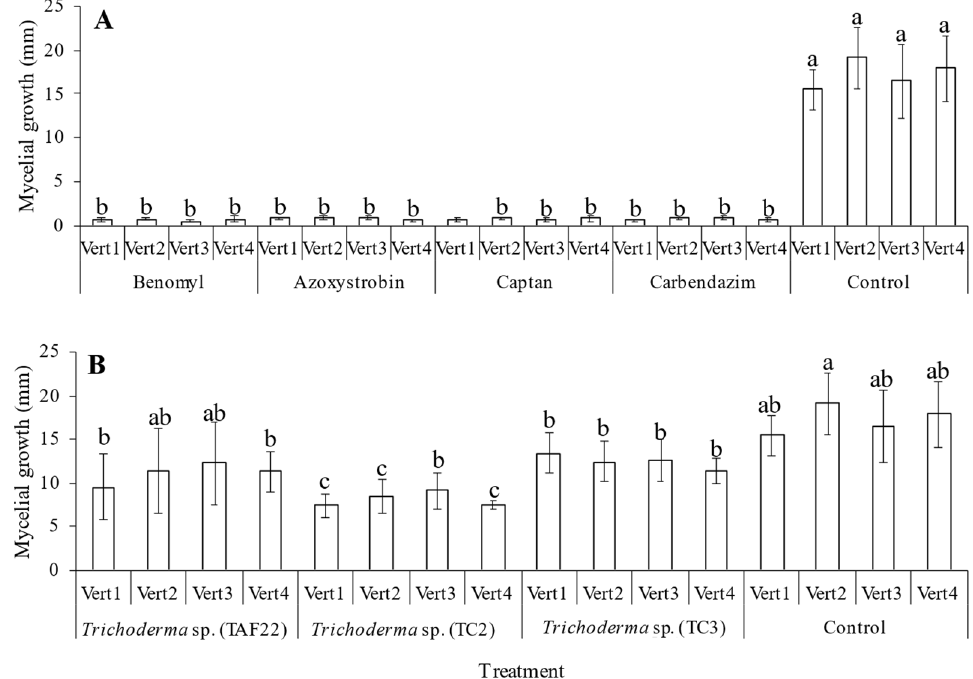
Figure 1. Effect of different treatments on in vitro growth of Verticillium dahliae . ( A ): effect of different chemical fungicides on growth of Verticillium dahliae . ( B ): effect of different strains of Trichoderma sp., on growth of Verticillium dahliae . Vert1-4 = code of strain of Verticillium dahliae . TAF22, TC2 and TC3 = code of morphotypes of Trichoderma sp. Error bars represent the confidence interval of the mean, validated by Tukey mean separation test. Equal letters indicate that there are no significant differences ( p > 0.05).